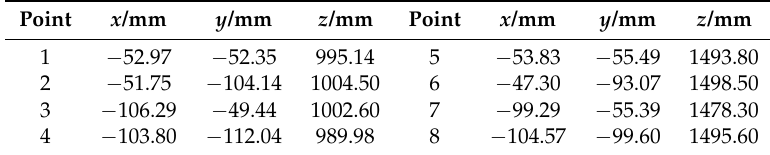
Table 7. The estimated 3D coordinates of the spatial points w.r.t the base frame O N − x N y N z N using ZED mini.